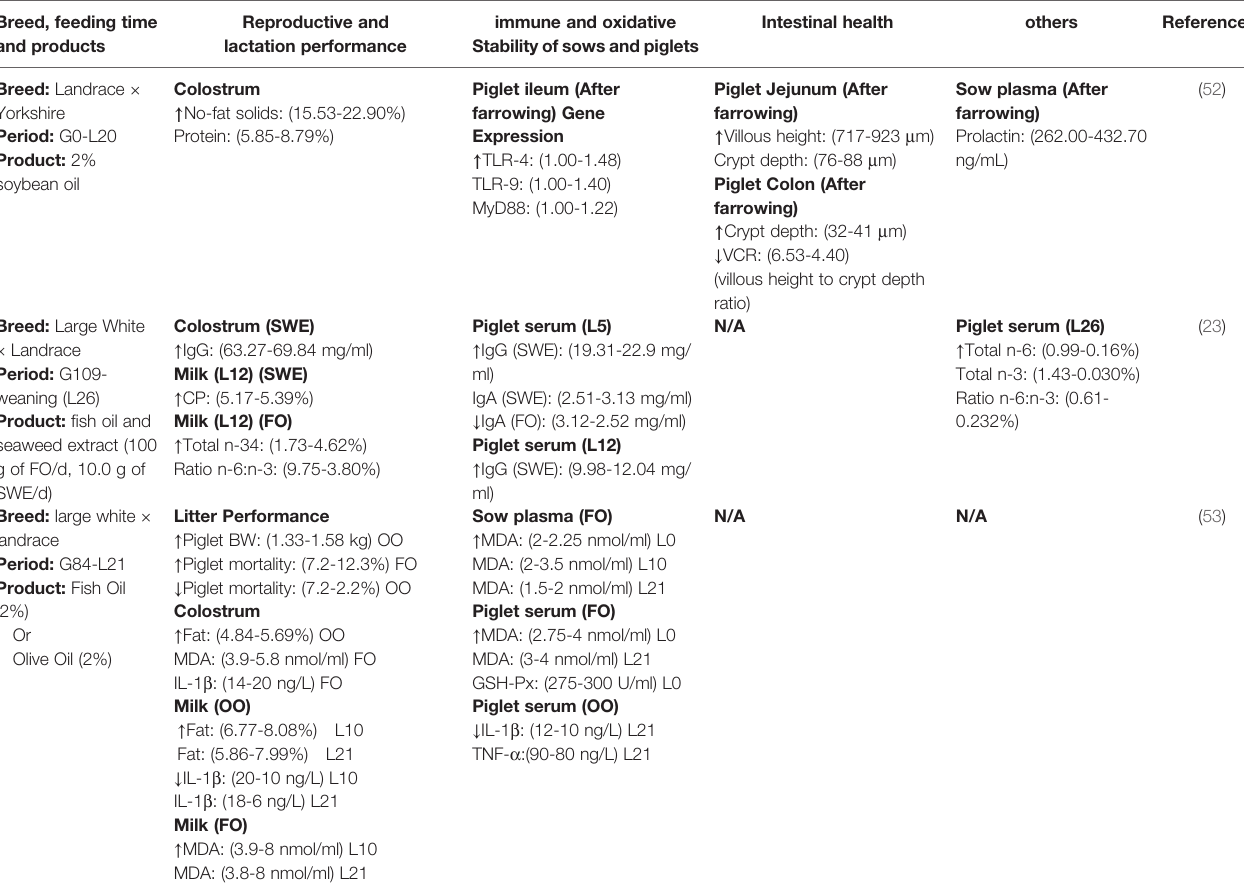
TABLE 2 | Maternal fats intake in the regulation of neonatal infection, immunity and production